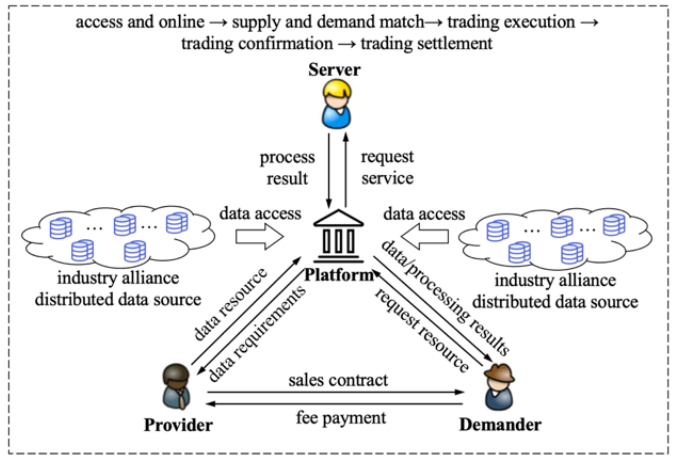
Figure 1. Schematic diagram of the whole process of data asset trading. Data access and online includes compliance review, standardization check, data catalog upload, dataset or data service demonstration sample upload.